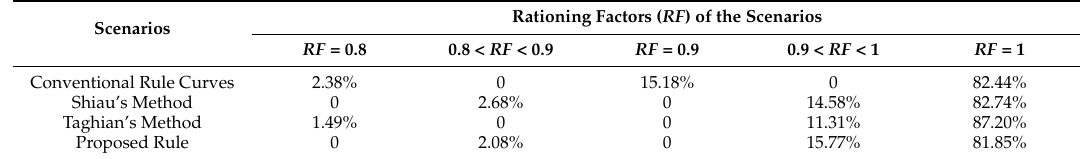
Table 3. The probabilities of rationing factors under different water supply